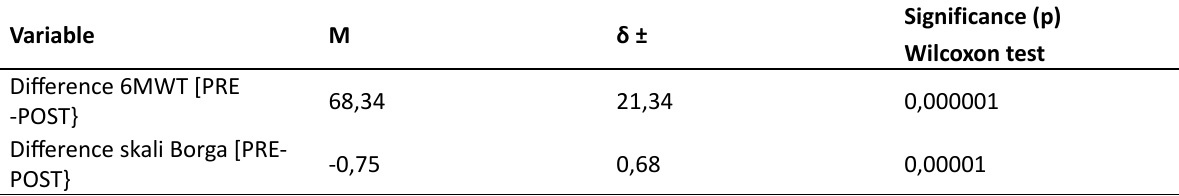
Table 2. Differences in 6MWT and Borg scale before and after the rehabilitation cycle Variable